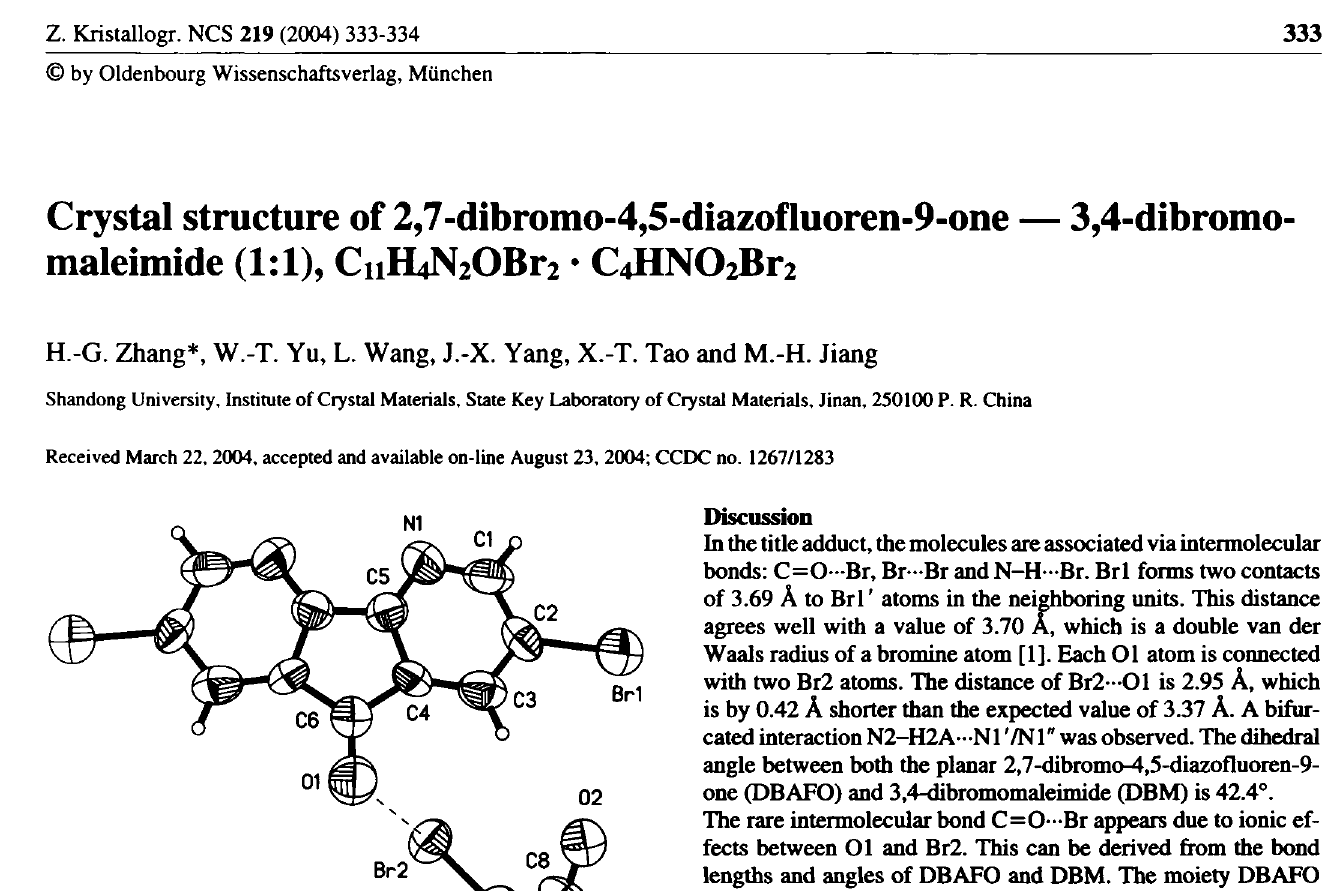
Table 1. Data collection and handling.